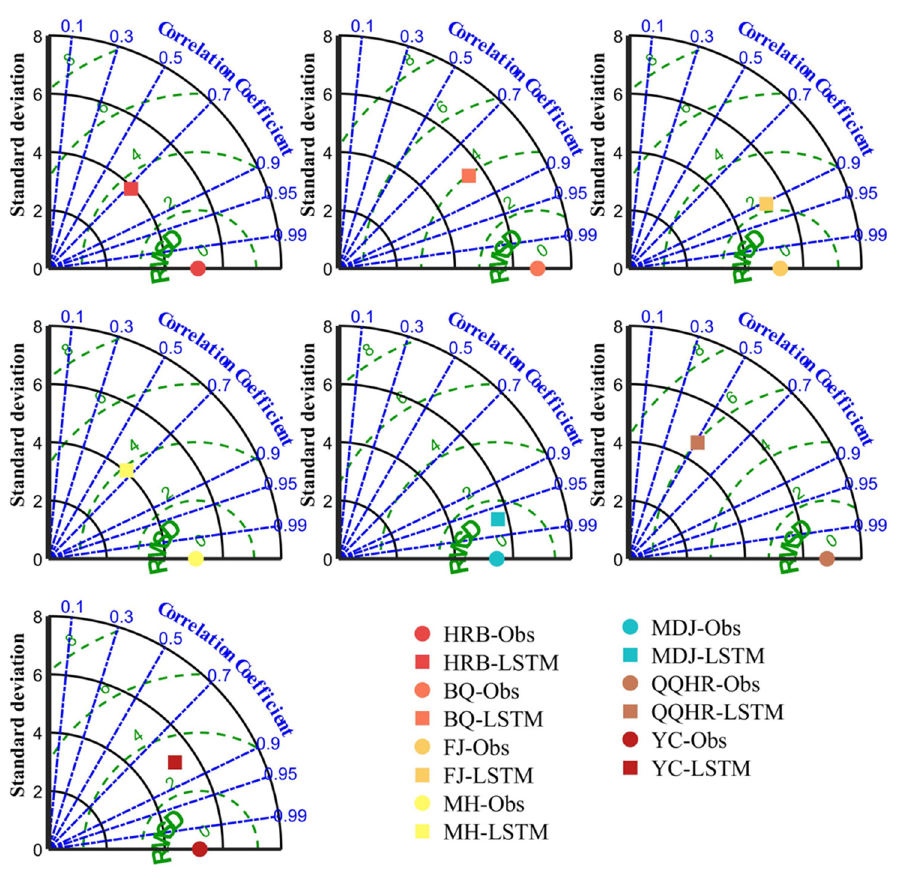
Figure 4. The Taylor diagram of LSTM at each station in Heilongjiang Province. Table 5. The S, RMSD, R, and SD of LSTM at each station.